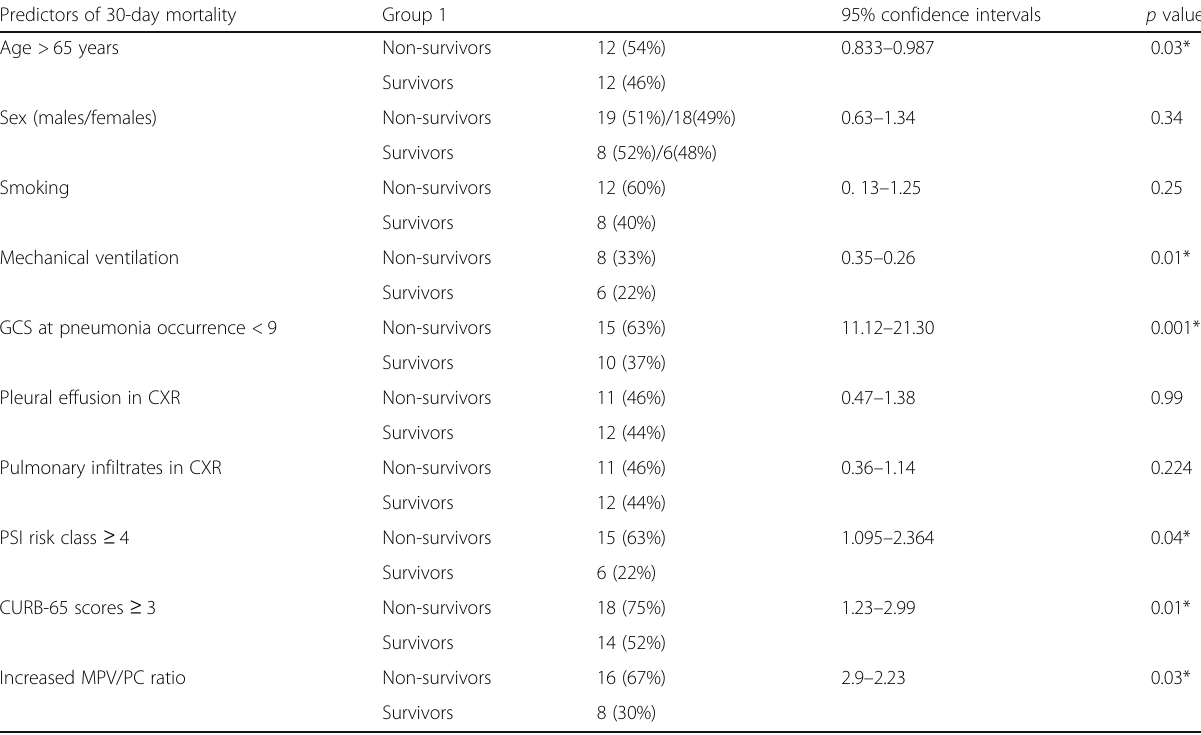
Table 4 Multiple regression analysis for predictors of 30-day mortality in group 1 Predictors of 30-day mortality